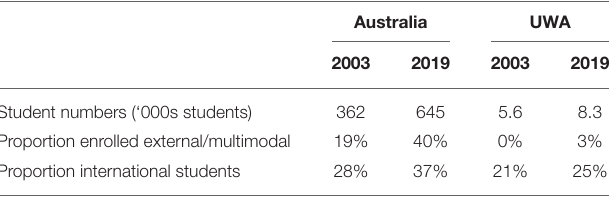
TABLE 2 | Context of student numbers, demographics and learning mode, nationally and at